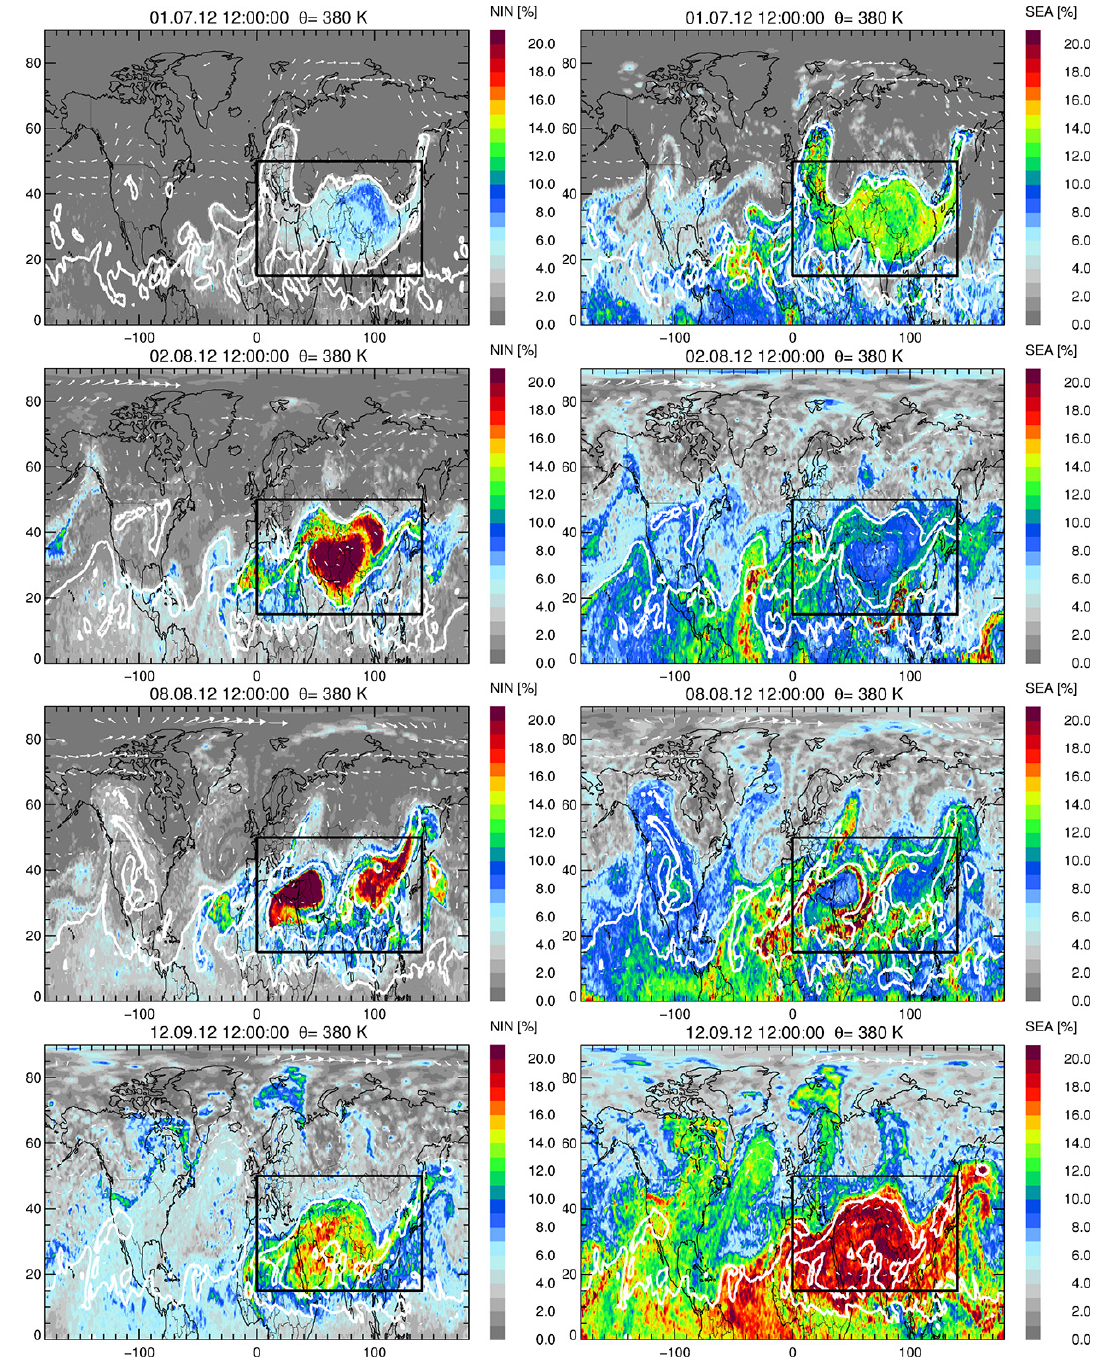
Figure 7. The horizontal distribution of the fraction of air originating in (left) northern India (NIN) and (right) Southeast Asia (SEA) at 380K potential temperature over Asia on 1 July 2012 (top), 2 August 2012 (second row), 8 August 2012 (third row), and 12 September 2012 (bottom). The horizontal winds are indicated by white arrows. The black rectangle (15–50 ◦ N, 0–140 ◦ E) highlights the region of the Asian monsoon anticyclone. The 4.5PVU surface marks roughly the edge of the anticyclone shown as a thick white line.